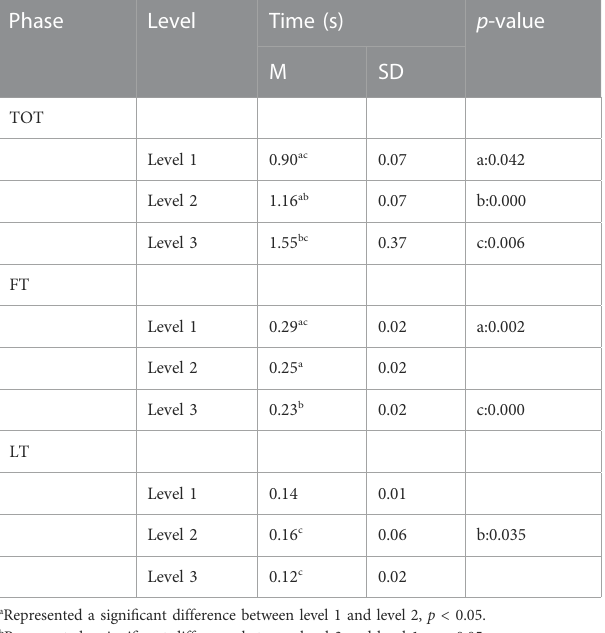
TABLE 4 FUS ’ s fl ying height of level 1, level 2, and level 3.